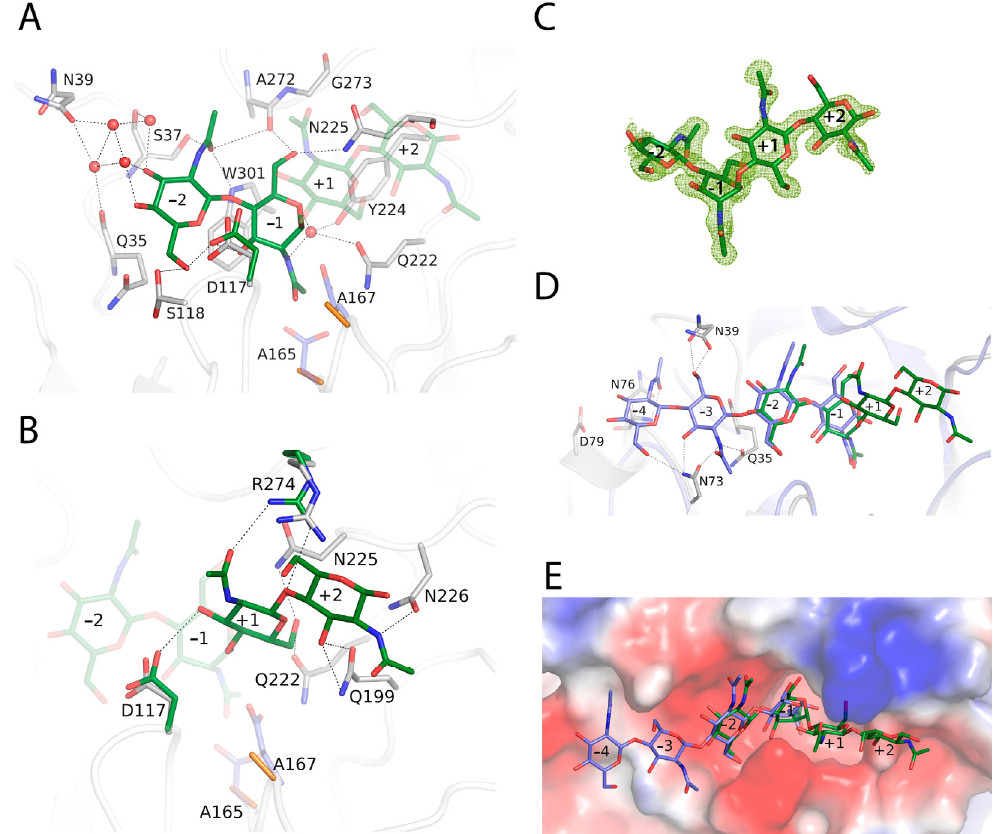
Figure 3. Structural details of the Chit33 active site. ( A ) Depiction of free and complexed Chit33 structures at the non-reducing ( A ) or reducing end ( B ). Catalytic resides are colored in slate/orange, and polar links are represented by dashed lines. Wild-type residues are represented by grey sticks, whereas residues showing conformational differences in the D165A/E167A-NAG4 complex are indicated by green sticks. ( C ) The final 2Fo-Fc electron density map at NAG4 moiety in the complex is contoured at 0.9 σ . ( D ) and ( E ) Extrapolation of additional binding subsites at the Chit33 non-reducing end by superimposing the hevamine-NAG4 coordinates (slate, PDB code 1KR0) onto the Chit33-NAG4 complex (grey and green). ( E ) Zoomed-in view of the molecular surface showing the electrostatic potential of the active site cavity.